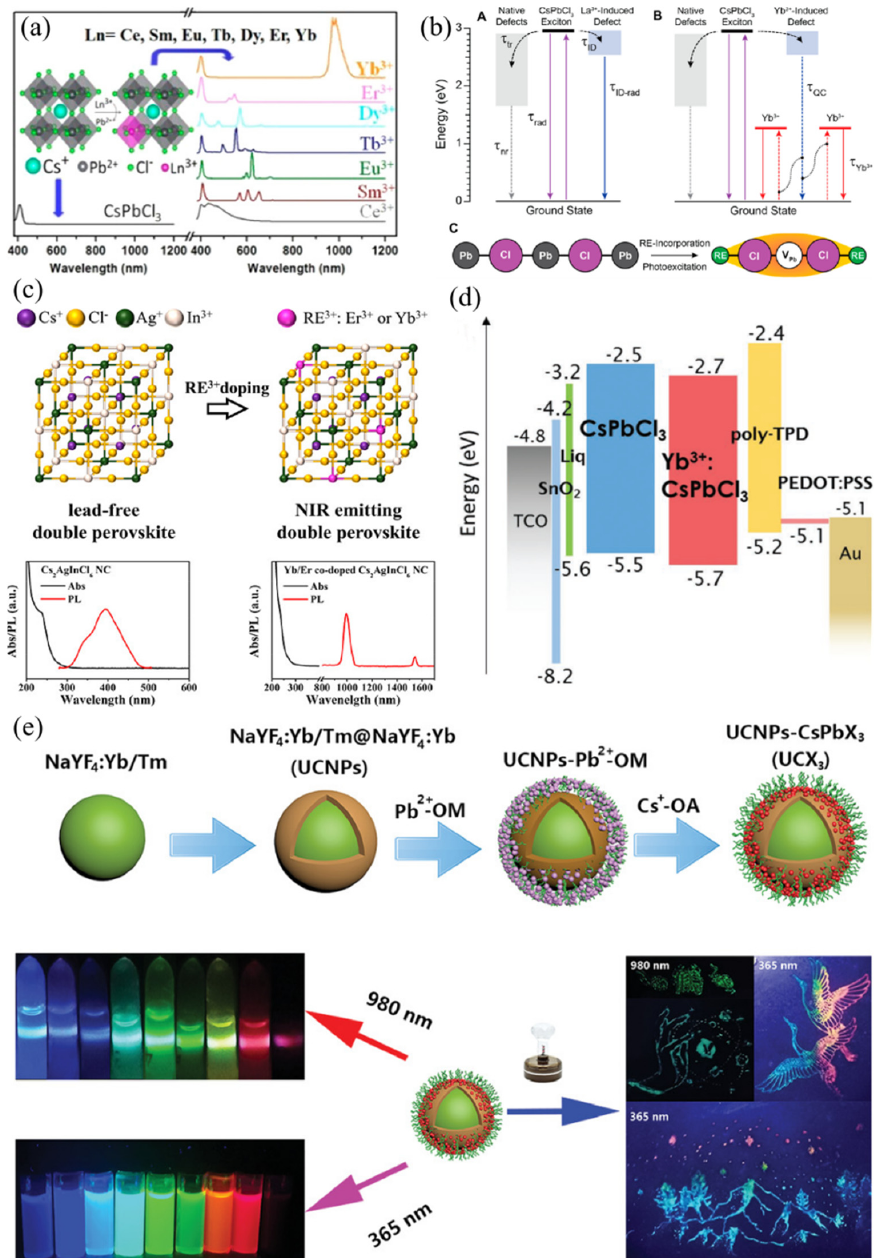
Figure 6. ( a ) Photoluminescence spectra of CsPbCl 3 nanocrystals with doping Yb 3+ , Er 3+ , Dy 3+ , Tb 3+ , Eu 3+ , Sm 3+ , Ce 3+ ions, respectively (Reprinted/adapted with permission from Ref. [69]. Copyright 2017 American Chemical Society); ( b ) Schematic maps for La 3+ - induced defect emission, Yb 3+ sensitization mechanism, and charge-neutral vacancy-defect structure of Ln 3+ -doped CsPbCl 3 nanocrystals (Reprinted/adapted with permission from Ref. [70]. Copyright 2018 American Chemical Society); ( c ) Crystal lattice structure of Cs 2 AgInCl 6 perovskite with doping Ln 3+ ions and the corresponding absorption/photoluminescence spectra (Reprinted/adapted with permission from Ref. [72]. Copyright 2019 American Chemical Society); ( d ) Energy-level diagram of perovskite LED with structure of TCO/SnO 2 /Liq/Yb 3+ :CsPbCl 3 /poly-TPD/PEDOT:PSS/Au (Reprinted/adapted with permission from Ref. [73]. Copyright 2020 Wiley-VCH); ( e ) Fabrication process of NaYF 4 :Yb/Tm@NaYF 4 :Yb UCNPs-CsPbX 3 (X=Cl, Br, I or mixed halide elements) for full color anticounterfeiting (Reprinted/adapted with permission from Ref. [75]. Copyright 2021 John Wiley and Sons).